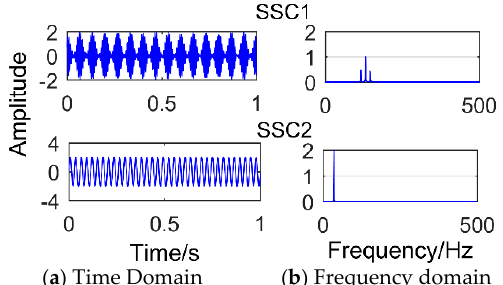
Figure 6. The results obtained by SSD for processing the synthetic signal when the amplitude of adding impact signal is 3.5.